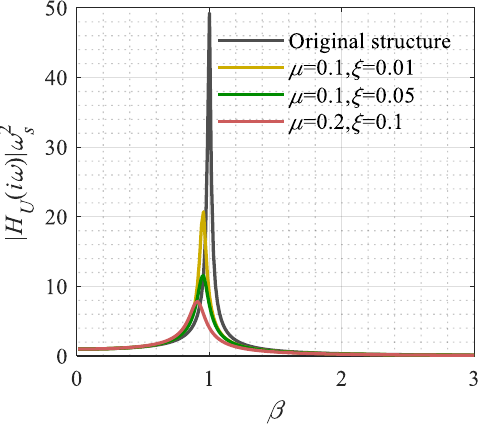
Figure 13. Displacement amplification factors of the SDOF structure with different inerter systems.